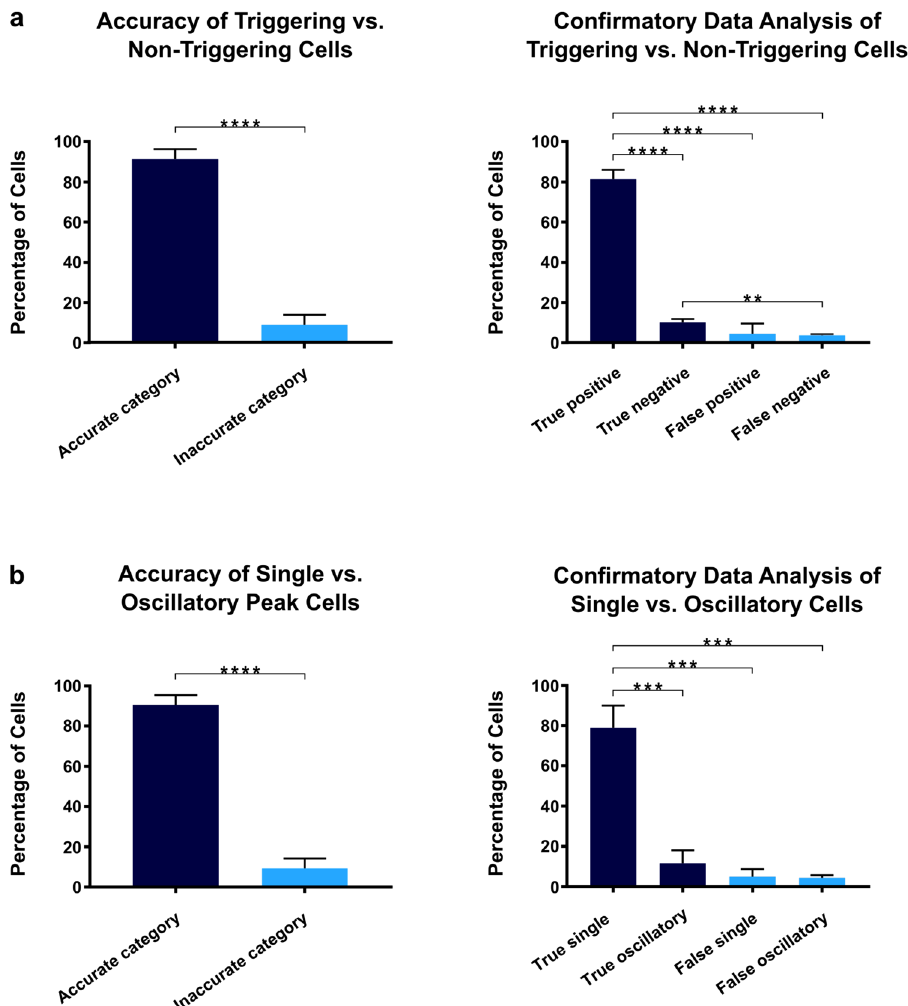
Figure 4. CalQuo 2 compared to manual classifications of Ca 2 + responses. Comparison of CalQuo 2 versus manual classification in 100 randomly selected cells in three replicates each of T cells that had landed on 9V:MHC functionalized coverslips. * Indicates p ≤ 0.05, ** indicates p ≤ 0.01, *** indicates p ≤ 0.001, **** indicates p ≤ 0.0001. ( a ) Comparison between CalQuo 2 and manual classifications of triggering and non- triggering cells. ( b ) Comparison between CalQuo 2 and manual classifications of single and oscillatory Ca 2 + peak cells. The figures on the left depict the percentage of cells whose Ca 2 + response CalQuo 2 categorized in a similar manner to the manual categorization with the manual categorization considered to be the accurate depiction of the Ca 2 + response. The figures on the right further detail the percentage of cells that were accurately classified, as well as the percentage of type I (false positive) and type II errors (false